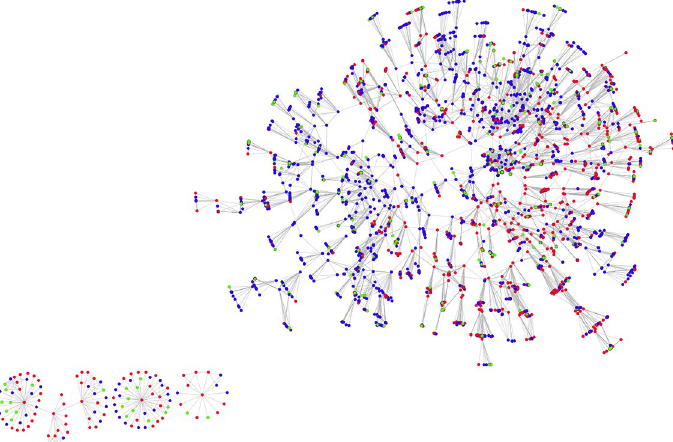
Fig 6. The network of networks. The network has 4,855 nodes, 5,477 arcs and 2,540 undirected ties. Colors indicate network nodes’ place of living, i . e . red (Castello ´ n, Spain), blue (Da ˆ mbovi ț a, Romania), and green (other countries). The network data was visually encoded with visone ( stress minimization node layout) [57].